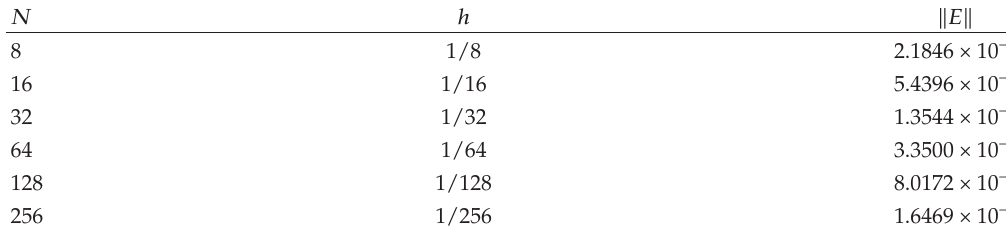
Table 2: Results for Example